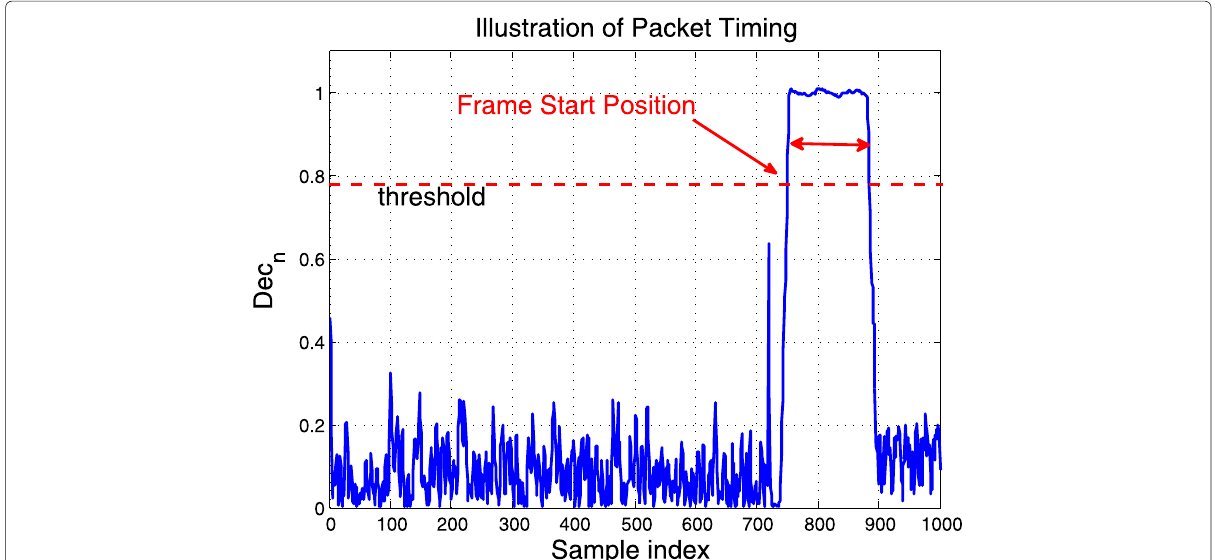
Fig. 3 Use delay and correlate algorithm to synchronize the incoming